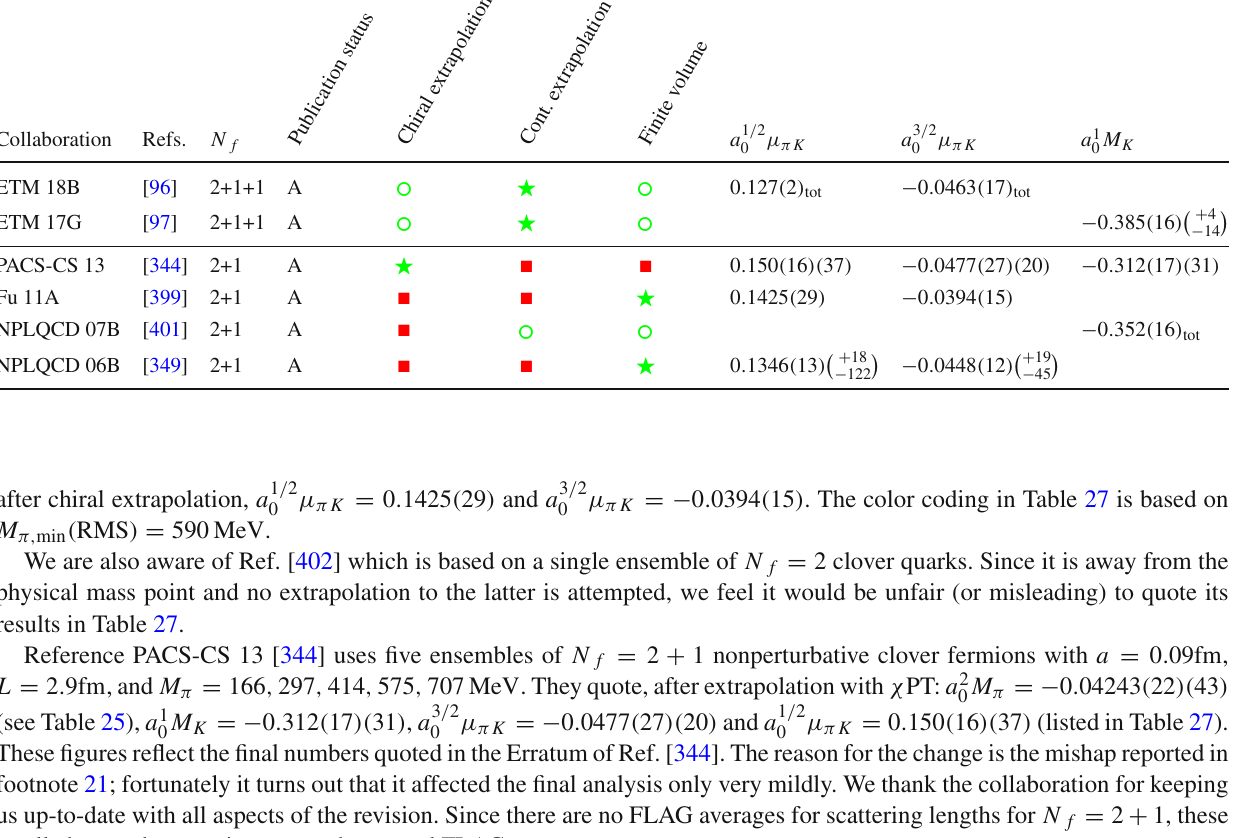
, 3 channels, and of K K scattering with I = 1. Some of the results have been adapted to 2 2